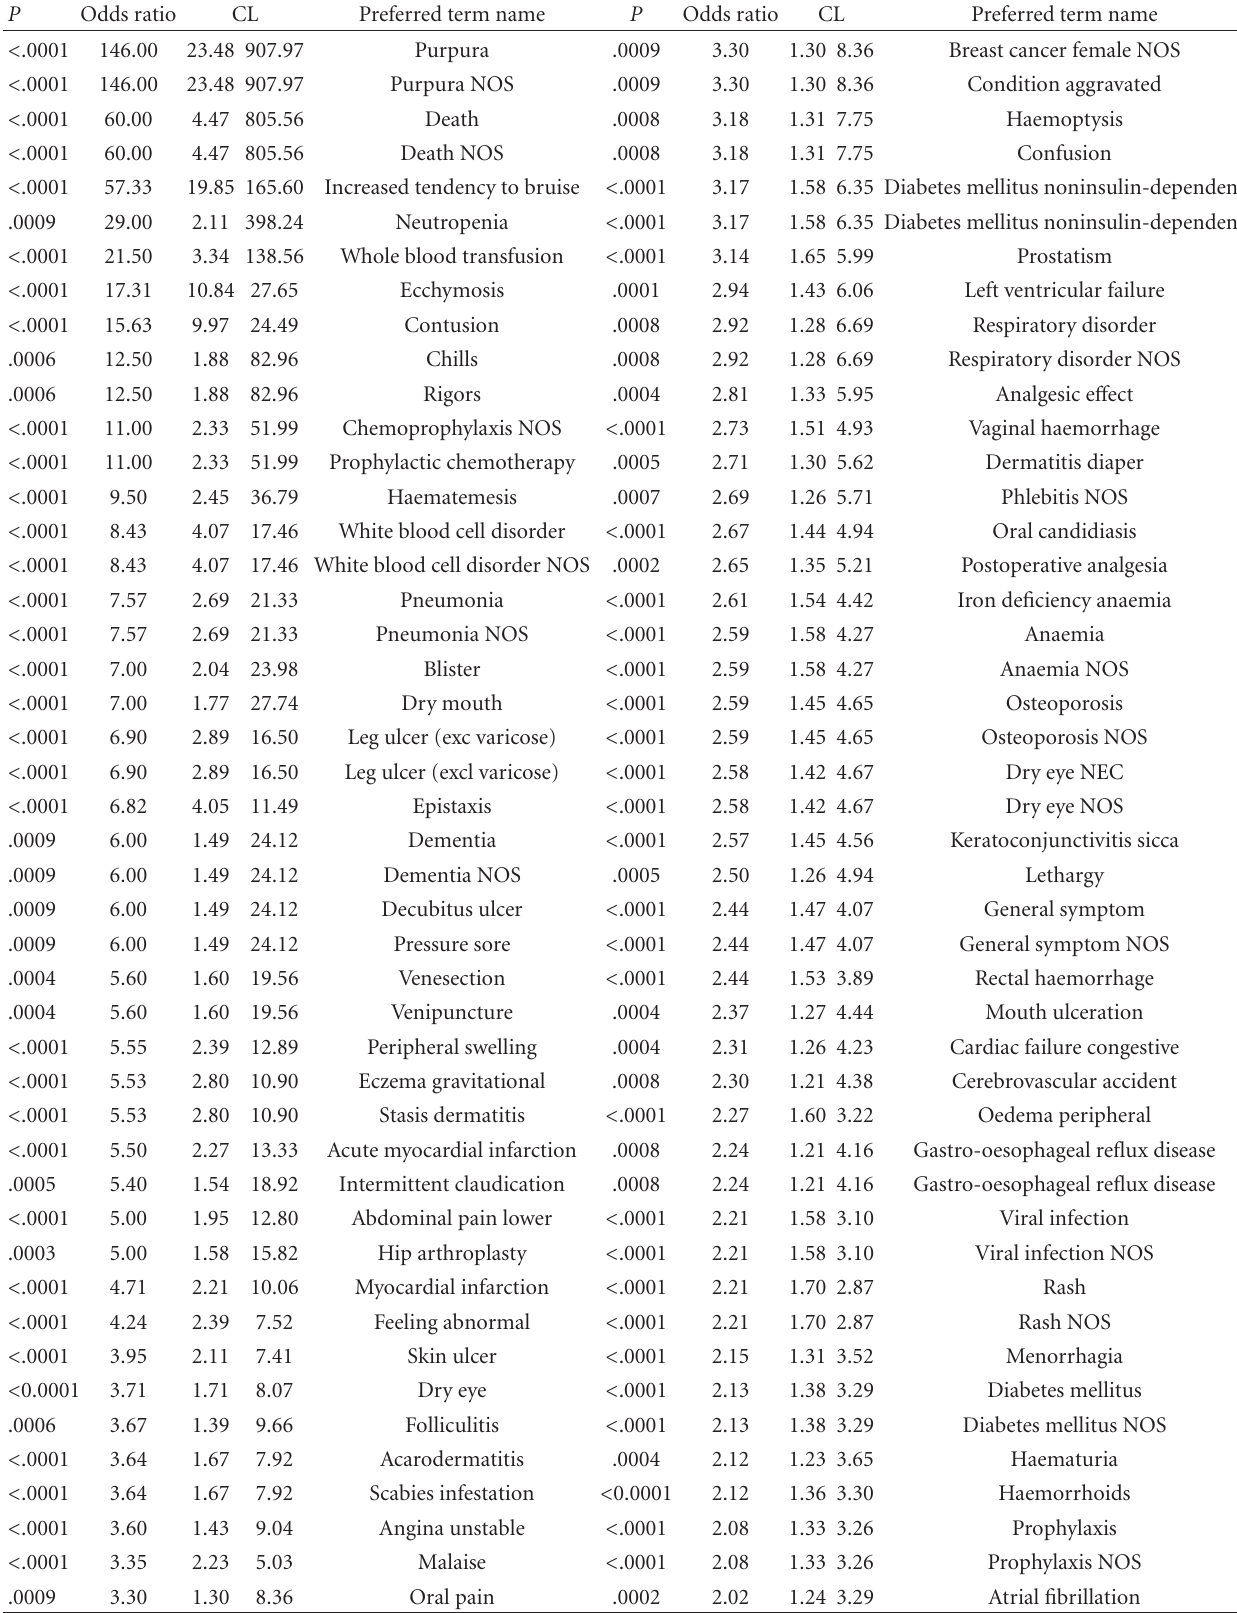
Table 3: Comorbidities significantly associated with ITP in the period or 2 years around diagnosis